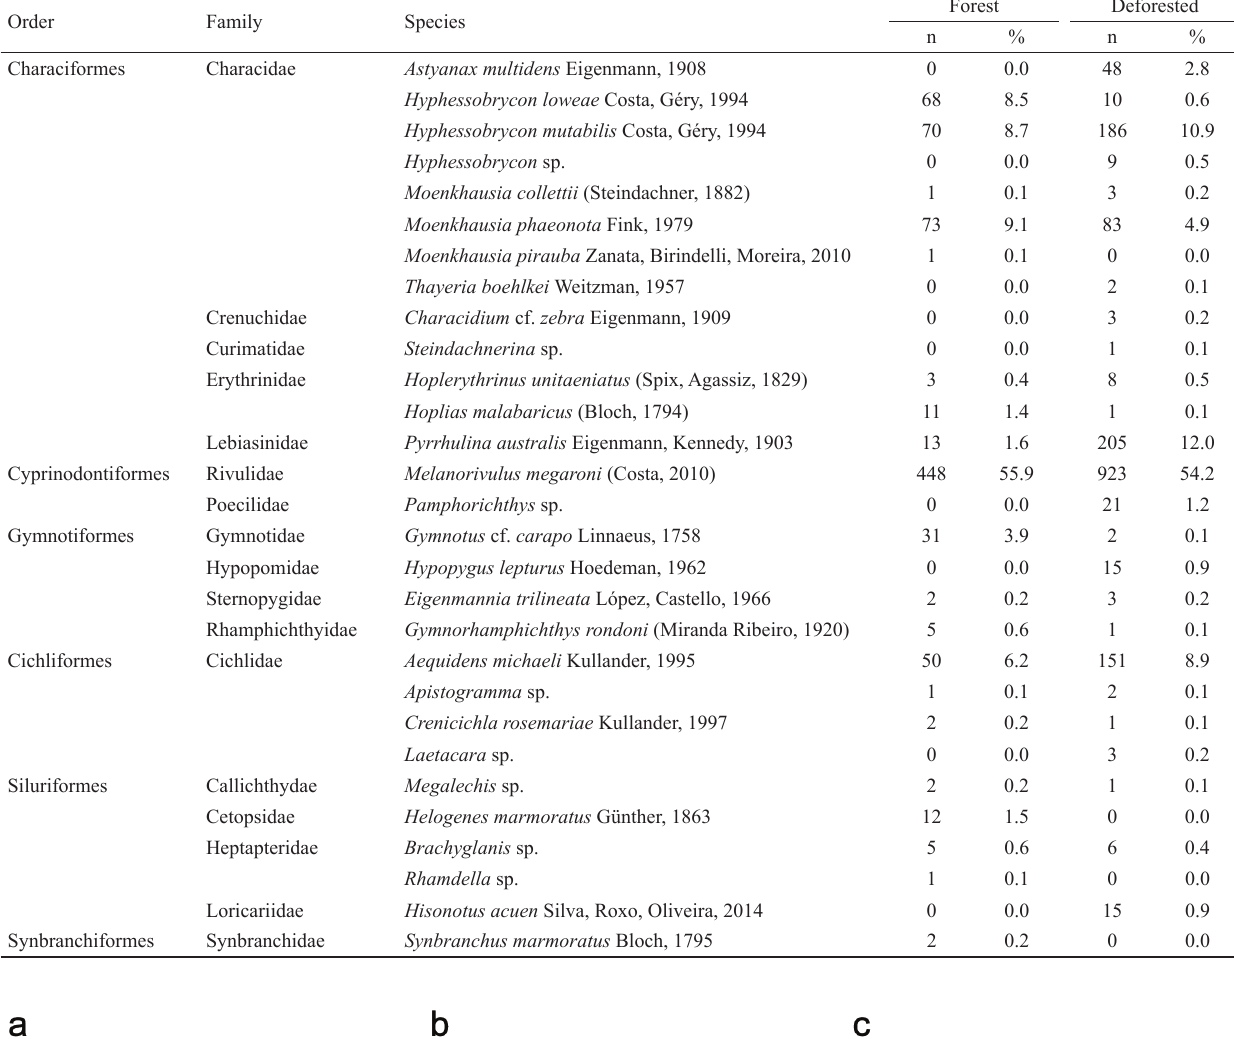
Tab. 2. Number of individuals collected (n) and relative abundance (%) of fish species in forest and deforested first-order stream reaches in the Upper Xingu River Basin.